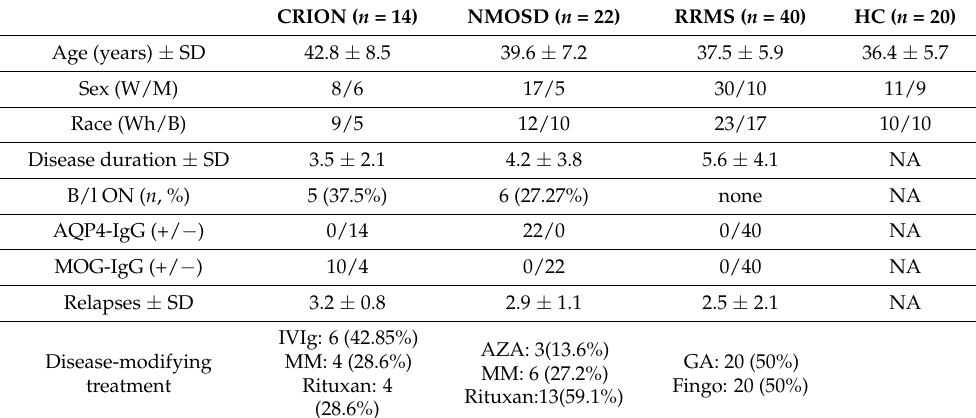
Table 1. Demographics and clinical characteristics of study